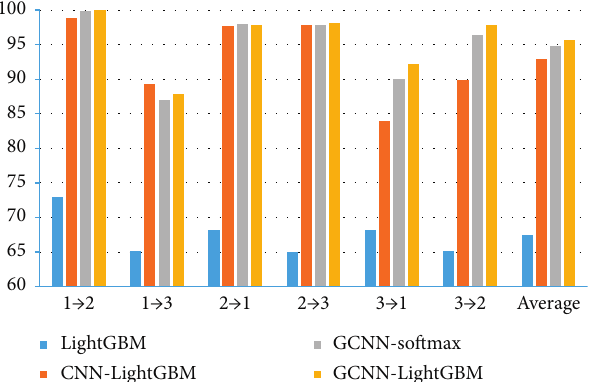
Figure 5: The classification accuracy of each model under different load conditions.